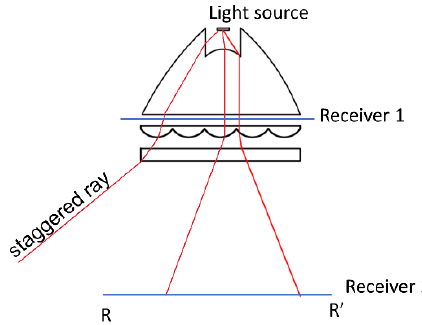
Figure 9. Illustration of the simulation structure for loss analysis and ray-tracing analysis.